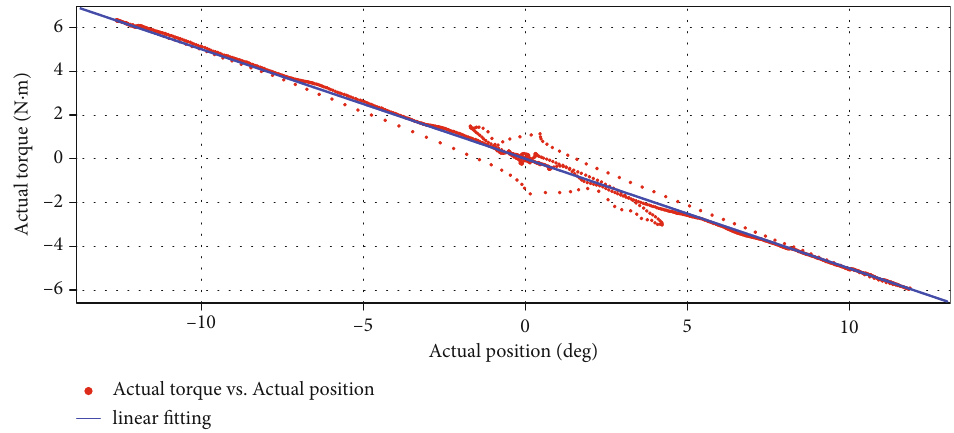
Figure 12: The actual torque change with the position of the hip joint and the fi tting straight line.